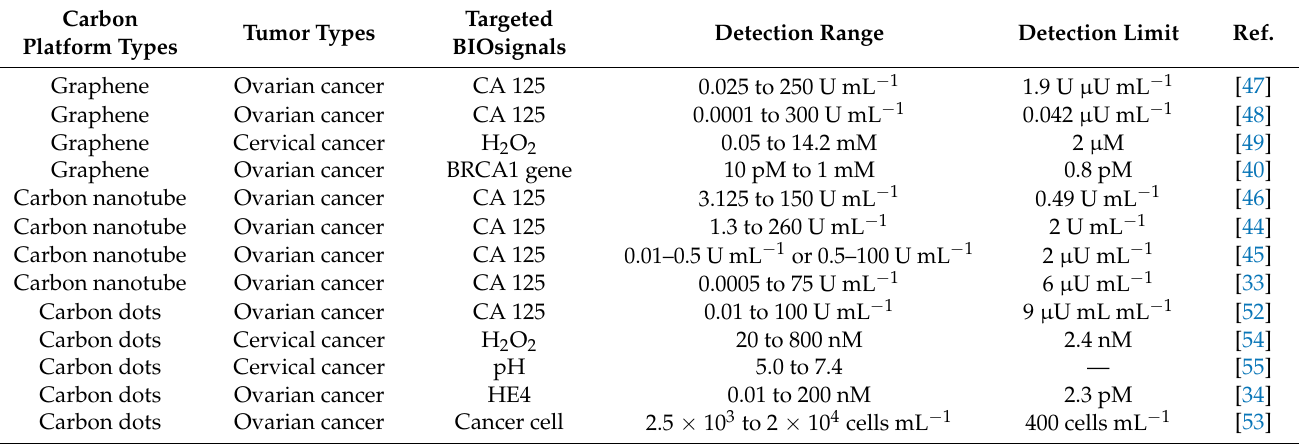
Table 1. The typical carbon-based nanomaterials for sensing various biosignals of gynecological